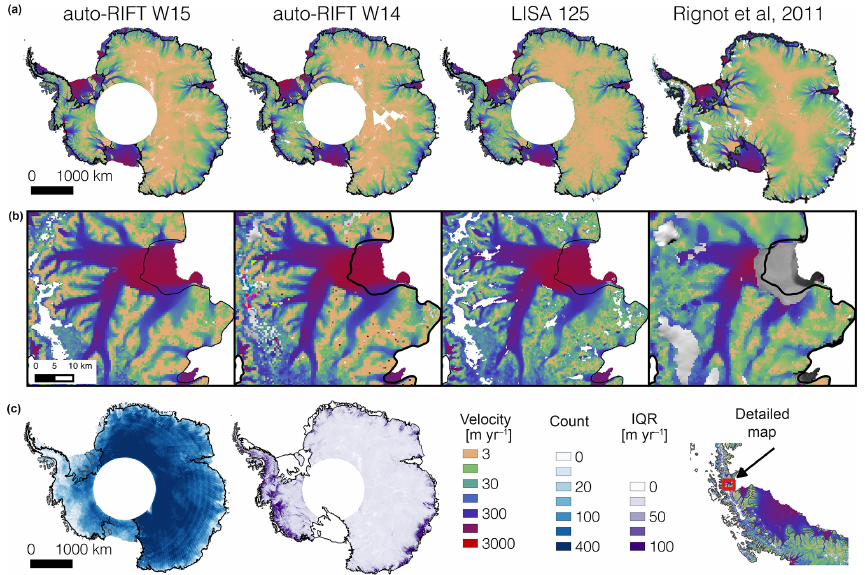
Figure 1. Comparison between JPL auto-RIFT error-weighted average, NSIDC LISA 125m and Rignot et al. (2011a) surface velocities. Panel a shows Antarctic-wide velocities; panel b shows close-ups of the Hektoria Glacier, located on the eastern side of the Antarctic Peninsula for spatial detail; and panel c shows valid image-pair velocity counts and their interquartile range (IQR) for the auto-RIFT W15 mosaic. Formal errors produced by auto-RIFT are unrealistically low so we display the IQR as a proxy for the per-pixel random